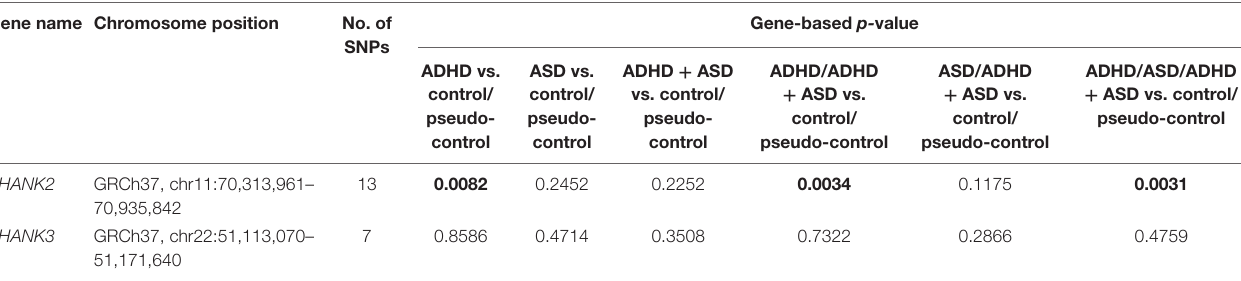
TABLE 3 | Gene-level association